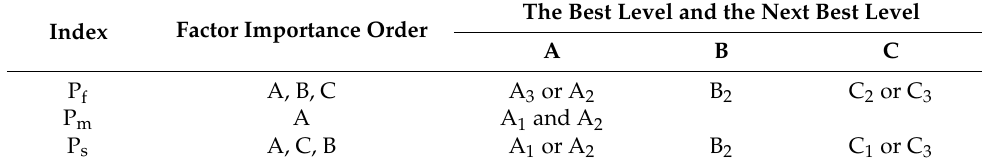
Table 5. Summary of results of unpressed